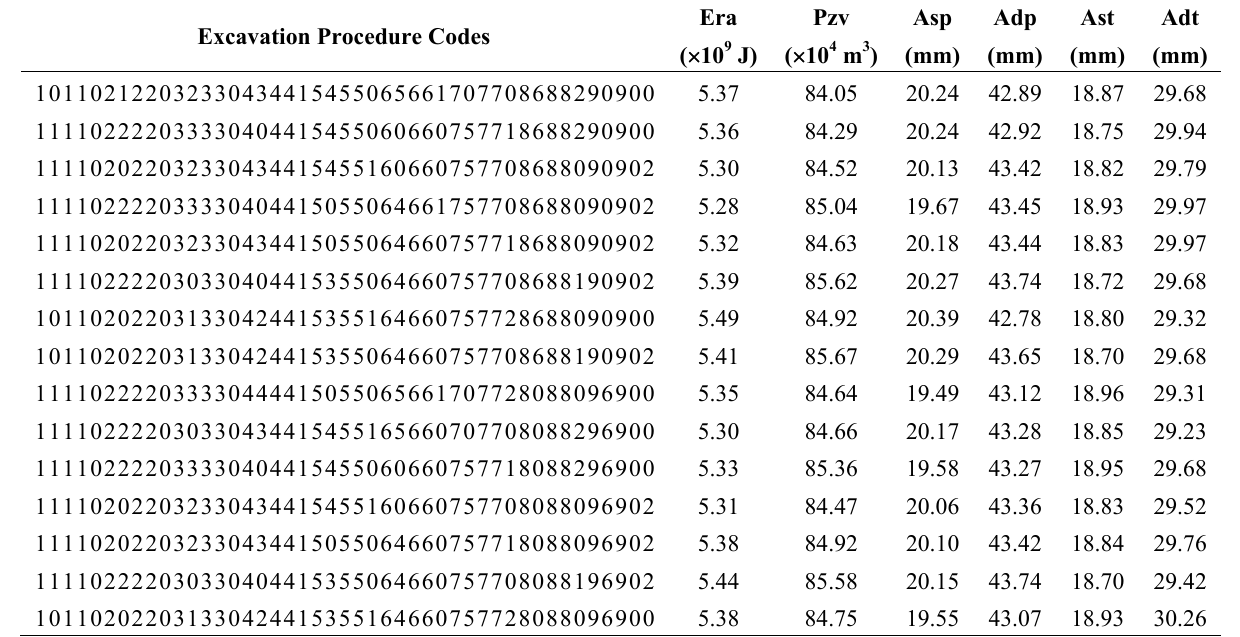
Table 1. Designed learning and testing sample sets for PSO-SVM. Excavation Procedure